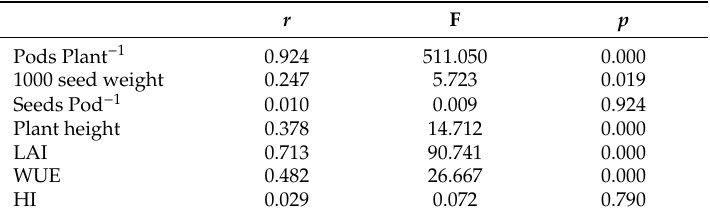
Table 2. Correlation coefficients between seed yield and parameters. HI: harvest index.